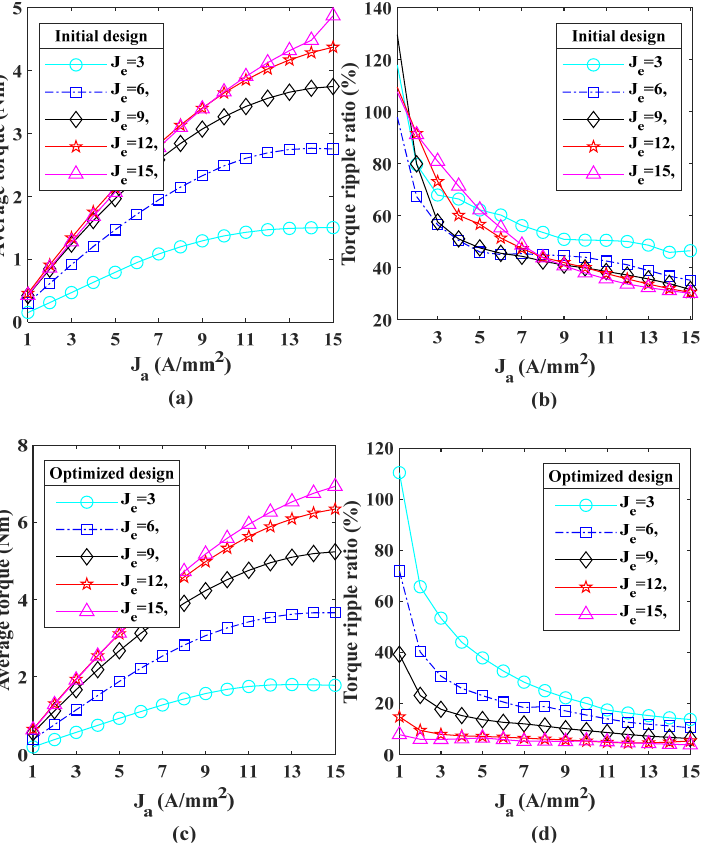
Figure 15. Overload capability of proposed design before and after optimization. ( a ) Torque w.r.t J a and J e before optimization; ( b ) ripples w.r.t J a and J e before optimization; ( c ) torque w.r.t J a and J e after optimization; and ( d ) ripples w.r.t J a and J e after optimization.